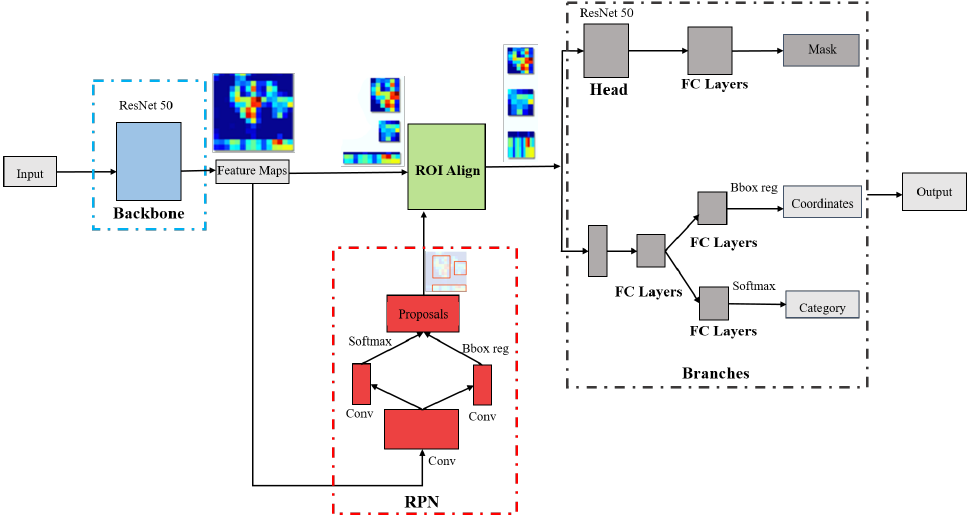
Figure 3. Overview of the Mask R-CNN Object